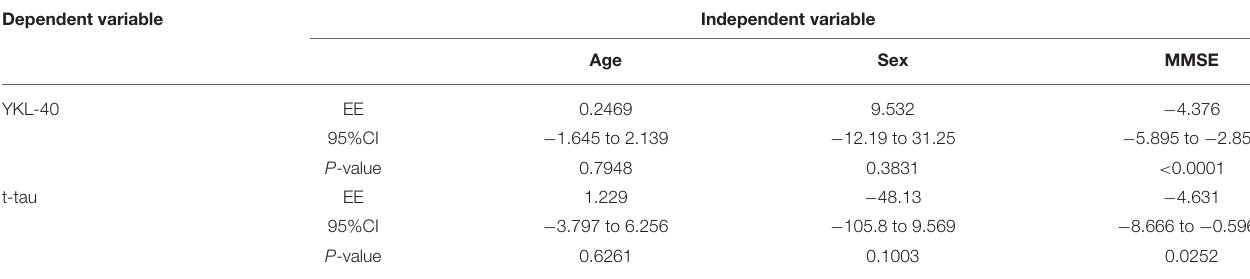
TABLE 5 | Multifactorial regression of YKL-40 and